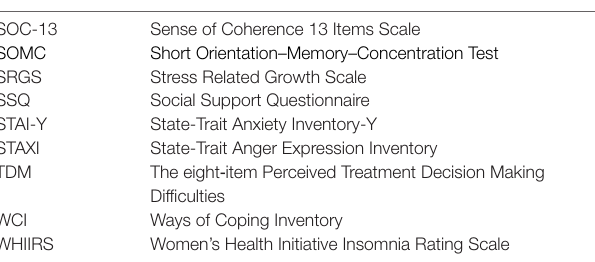
TABLE 2 | Psychometric instruments used in eligible